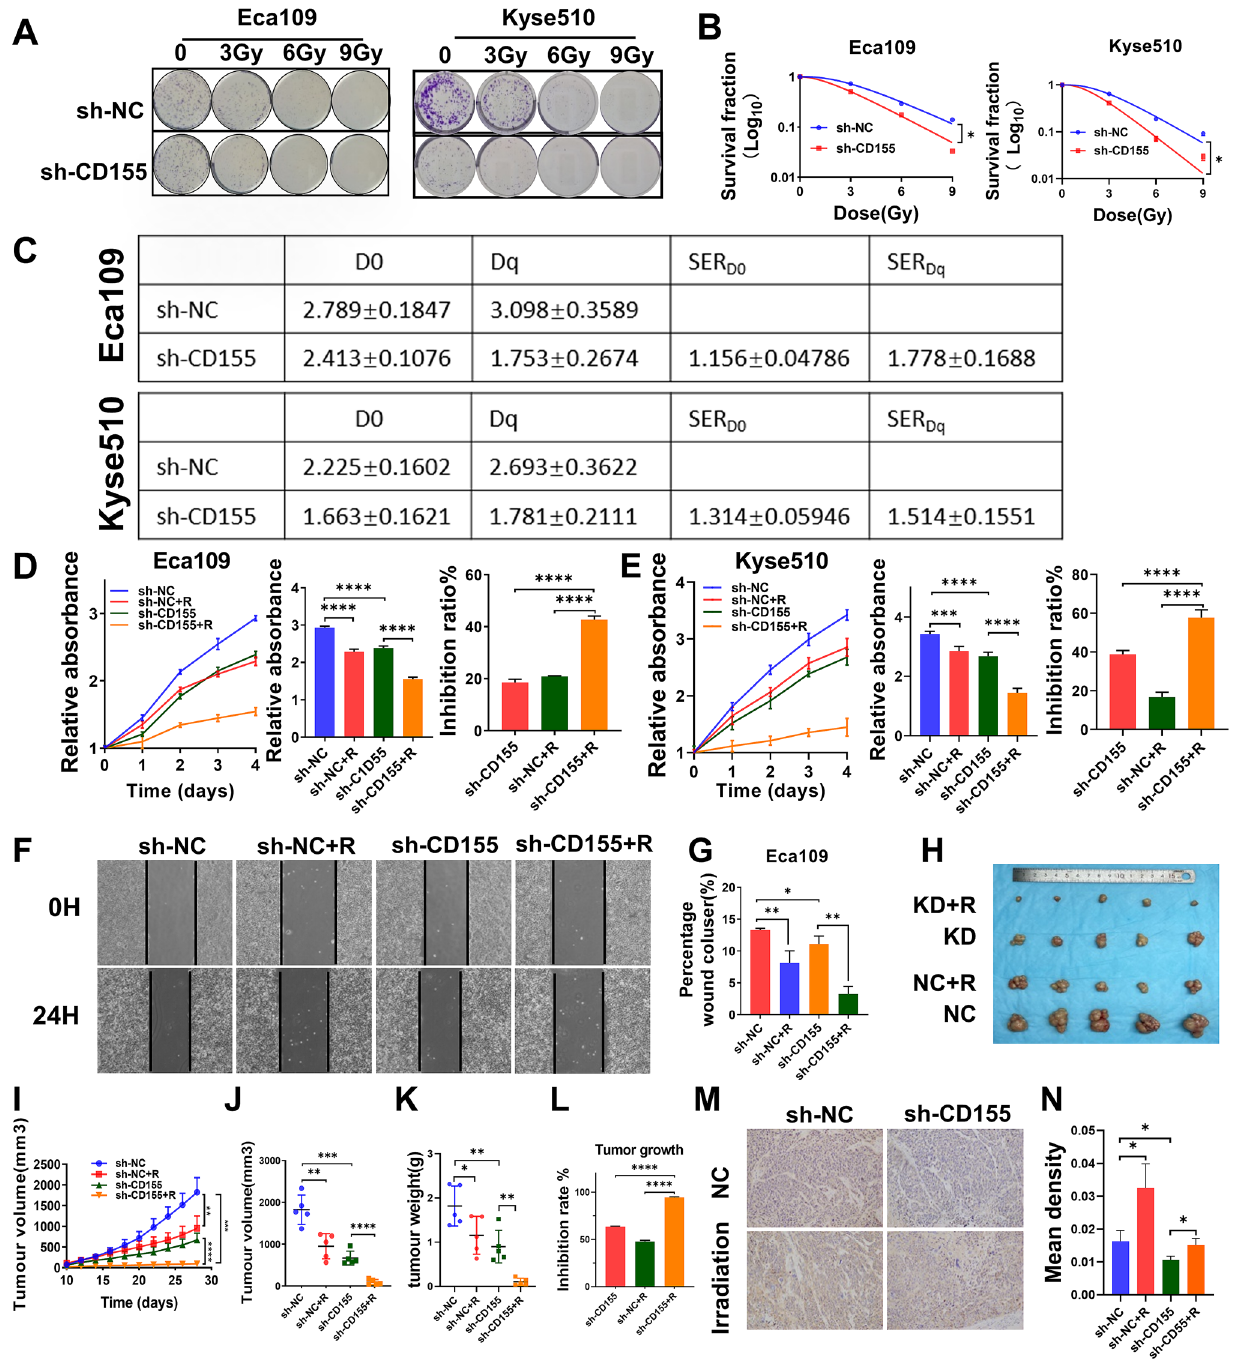
Fig. 4 Knockdown of CD155 enhances radiosensitivity of EC. A Colony formation analysis of Eca109 and Kyse510 cells stably expressing sh-CD155 or sh-NC after exposure to 0, 3, 6, and 9 Gy of radiation. B Survival curves were obtained based on the clonal efficiency assay. Data are presented as the mean ± SD of independent experiments (n = 3). C D0, Dq, SER D0 , and SER Dq were calculated using the single-hit multitarget model. D , E Eca109, and Kyse510 cells expressing sh-NC or sh-CD155 were exposed to radiation, and cell viability was analyzed using the CCK8 assay. Left: CCK8 assay results; middle: statistical analysis of CCK8 assay; right: IR of cell viability was calculated and presented as mean ± SD (n = 3). **** P < 0.0001, two- tailed unpaired t-test. F wound-scratch assays were imaged immediately after the initial scratch (T0) and 24 h later. G Quantification of the relative cell migration in the wound-scratch assay. H – L Tumors from different groups (sh-NC, sh-NC + R, sh-CD155, and sh-CD155 + R) were xenografted in nude mouse and collected 28 days later. H Tumor images. I Tumor growth curve in nude mice, p-values were calculated using a two-tailed unpaired test. J Tumor volumes were recorded every three days and are expressed as the mean ± standard deviation (n = 5). K Tumor weight was measured in each case. L The IR on xenograft growth was calculated based on the tumor volume and shown as mean ± SD (n = 5). *, ** p < 0.05, *** p < 0.001, **** p < 0.0001, two-tailed unpaired t-test. M Representative IHC images showing CD155 in xenografts from Eca109 cells (magnification, ×100). N Statisti- cal analysis for metastasis in nude mice shown in ( M ). *, ** p < 0.05, *** p < 0.001, **** p <